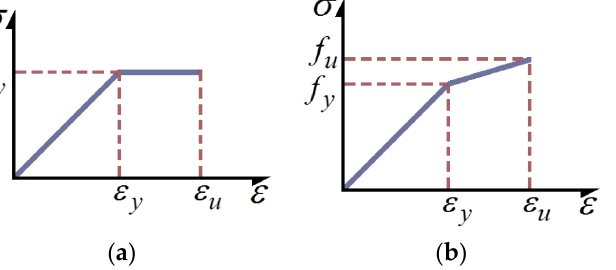
Figure 3. The representation of the: ( a ) adopted constitutive model for reinforcement steel; and ( b ) timber. Table 3. Steel bar elastic and plastic properties. Source: Luca and Marano